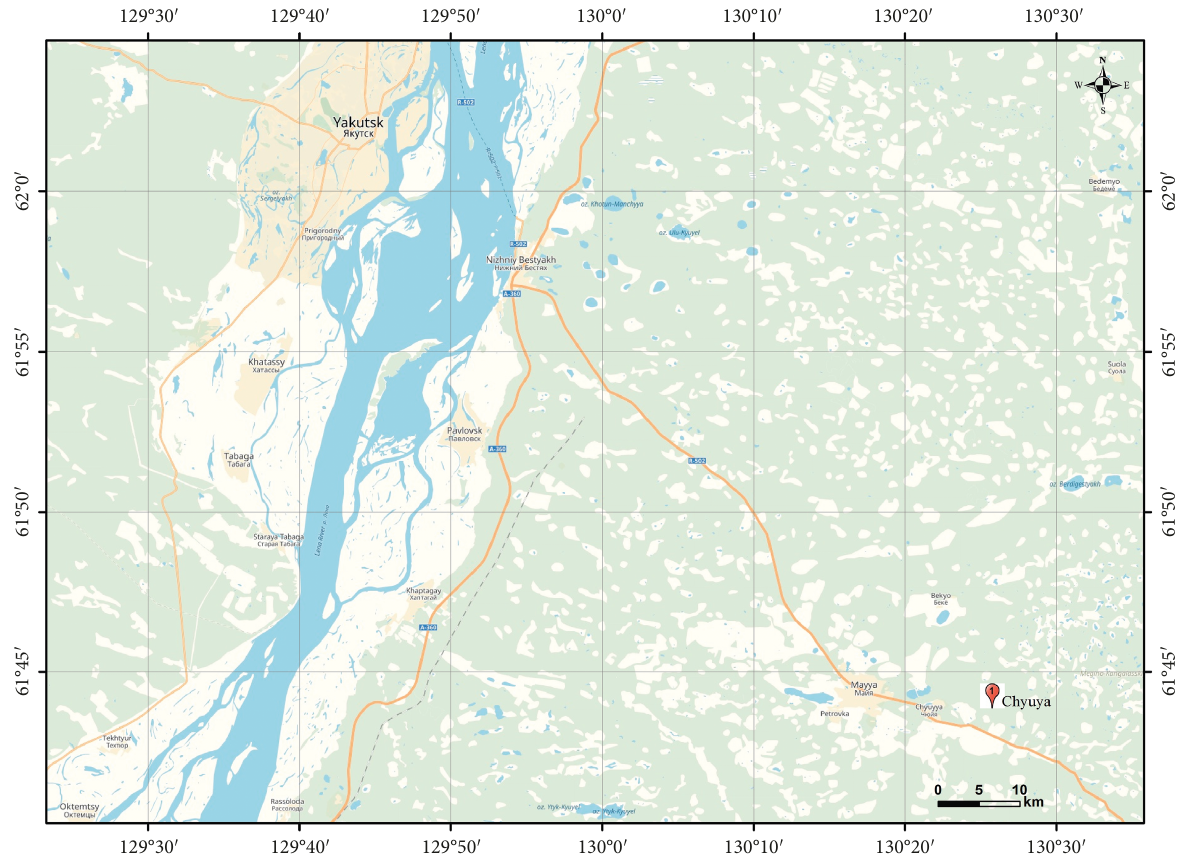
Figure 1: Location of the study area “Chyuya,” shown on a scheme of the region.